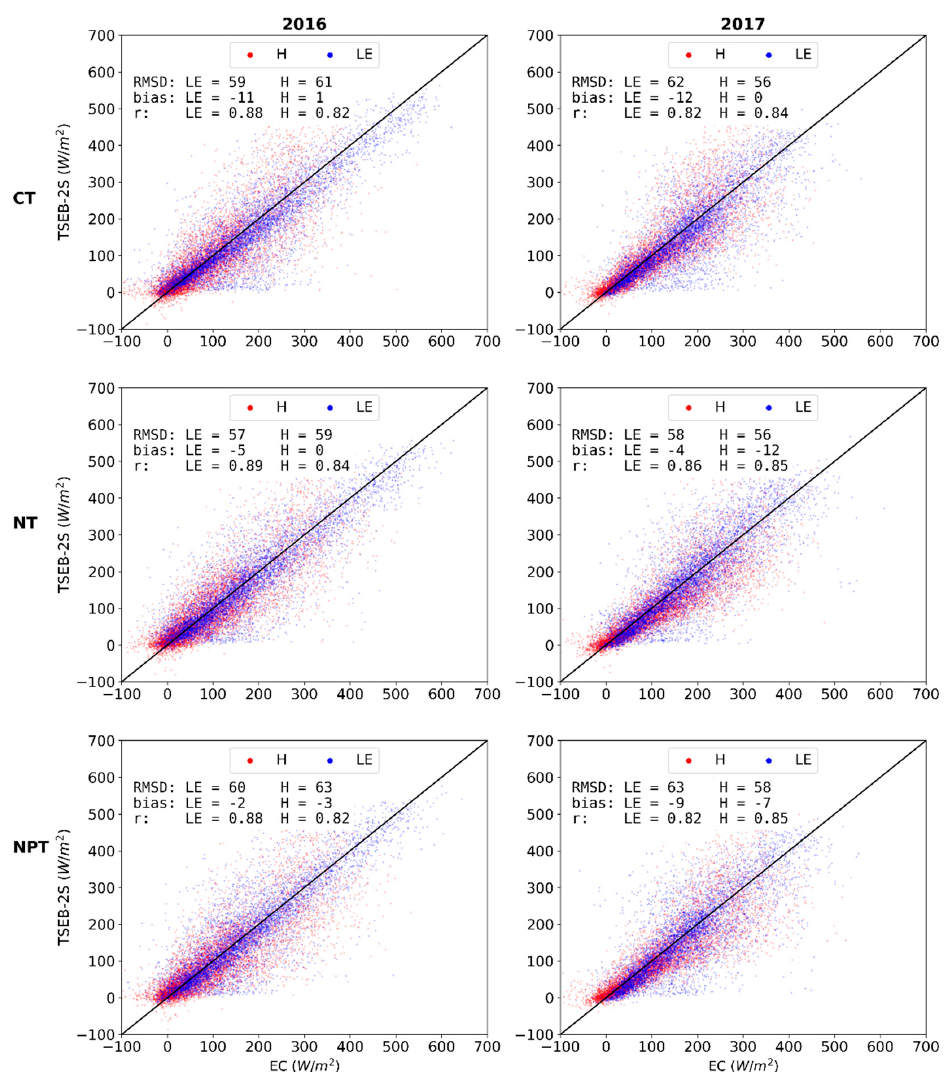
Figure 9. Observed vs modeled daytime half-hourly H (red) and LE (blue) density scatterplot for TSEB ‐ 2S for CT, NT and NPT; and years 2016 (left column) and 2017 (right column).